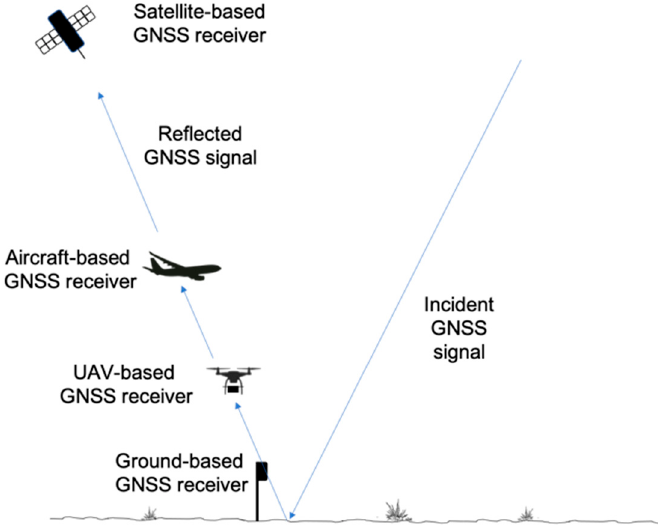
Figure 3. Platforms used for GNSS-R: ground-based, UAV-based, aircraft-based, and satellite-based.